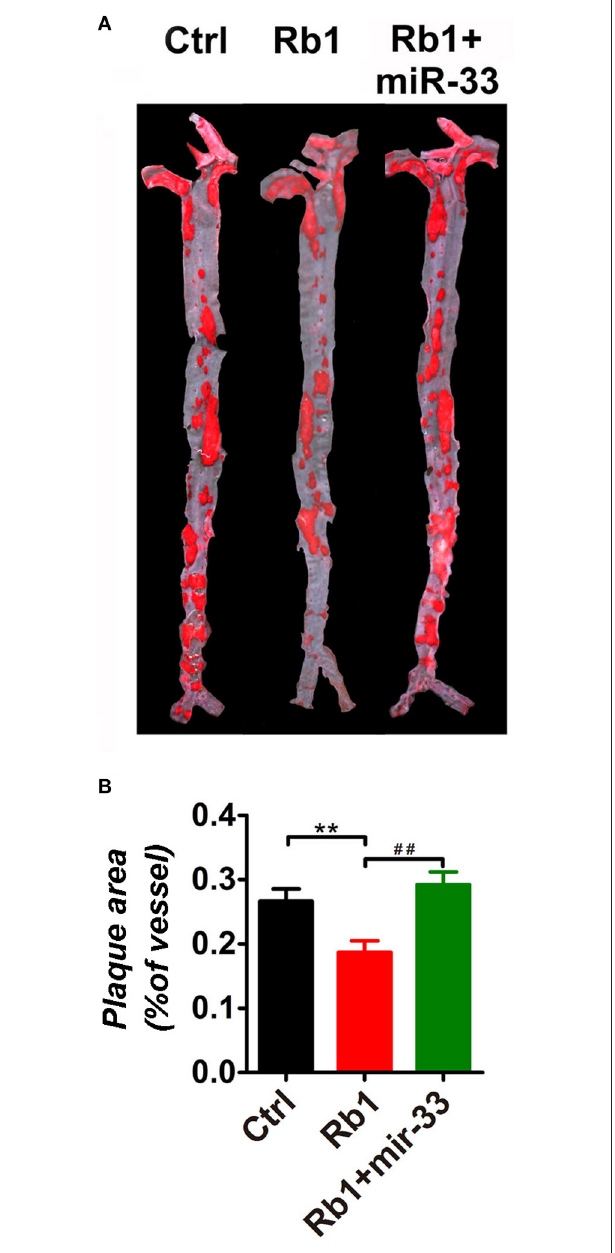
FIGURE 1 | Rb 1 attenuated atherosclerotic plaque growth in apoE − / − mice. (A) General oil red O staining of en face atherosclerotic aorta stem of control group, Rb 1 -treated group as well as Rb 1 + miR-33 treated apoE − / − mice ( n = 15/group). (B) Quantification of the ratio of plaque area vs. the total aorta stem area in control, Rb 1 -treated as well as Rb 1 + miR-33 treated groups ( n = 15/group). ** p < 0.01; ## p < 0.01, one-way ANOVA.